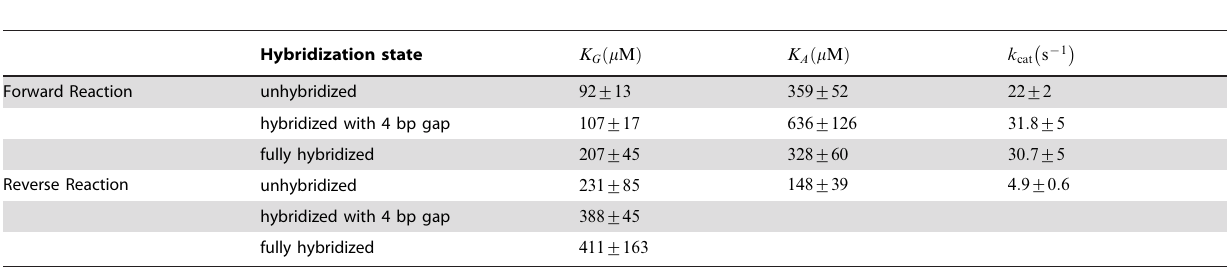
Table 1. The kinetic parameters K G , K A , and k cat extracted from the titration data for the forward direction (formation of GDP and ADP) and the reverse reaction (formation of GMP and ATP) in high Mg conditions.